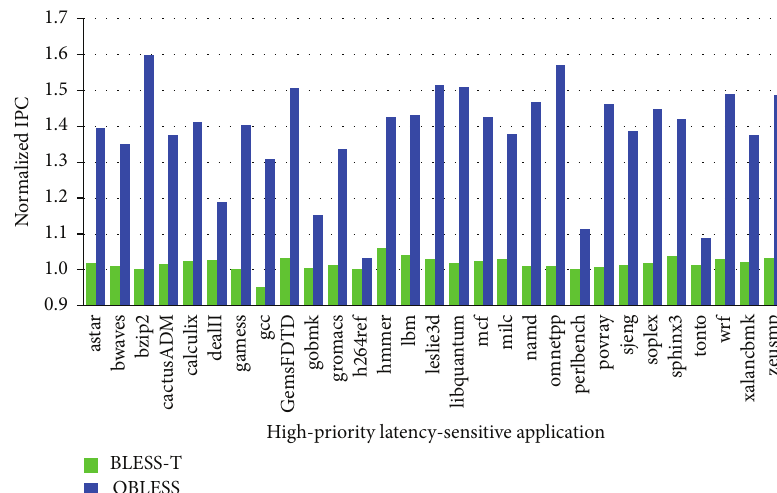
Figure 12: Performance of high-priority applications (100 cores, normalized to